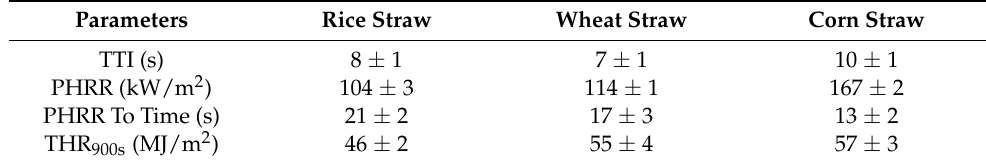
Table 3. Results of the cone calorimeter test.